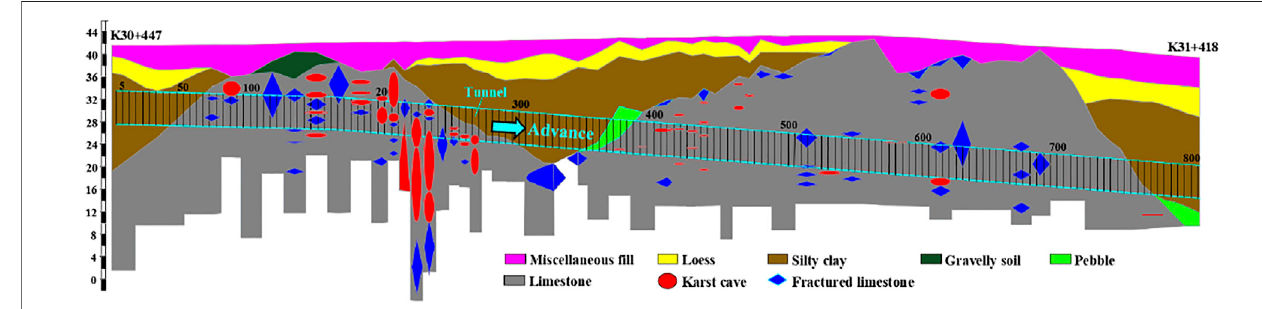
FIGURE 2 | Geological pro fi le of the limestone tunneling section.